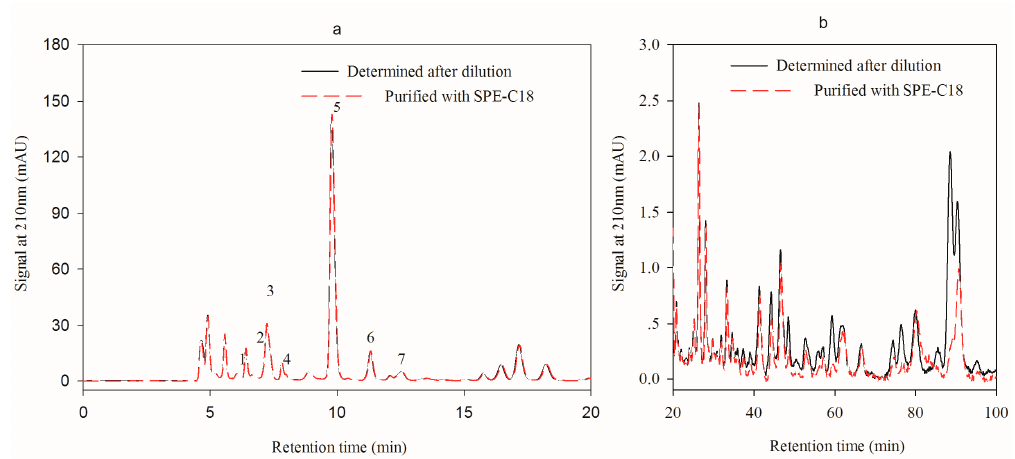
Figure 4. Effect of LC ‐ 18 SPE tube pretreatment on the analysis of HPLC method 2 ( a ), chromatogram of the first 20 min elution, Peak 1, 2, 3, 4, 5, 6 and 7 were pyruvic acid, L ‐ malic, lactic acid, acetic acid, citric acid, succinic acid and fumaric acid; ( b ), chromatogram of the 20–100 min elution.